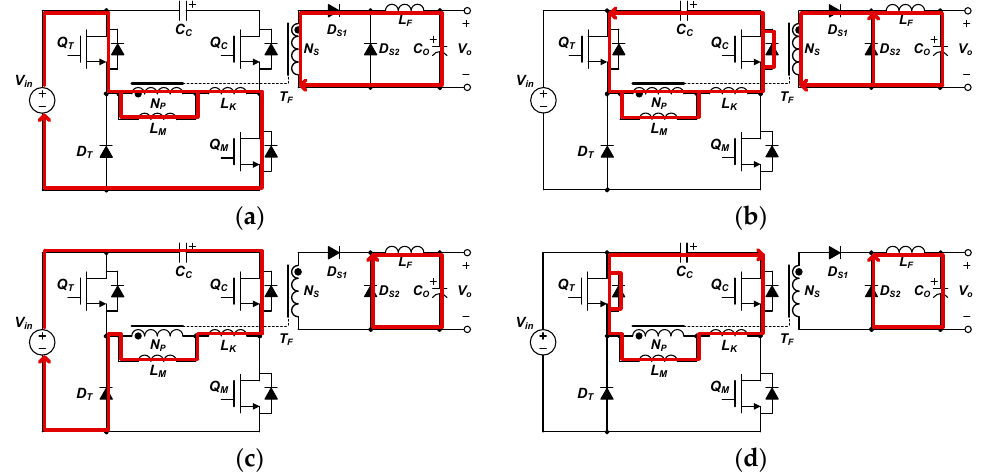
Figure 6. Operation modes of voltage controllable three ‐ switch active ‐ clamp forward converter : ( a ) Mode 1 (t 1 ~t 2 ), ( b ) Mode 2 (t 2 ~t 3 ), ( c ) Mode 3 (t 3 ~t 4 ), ( d ) Mode 4 (t 4 ~t 5 ).